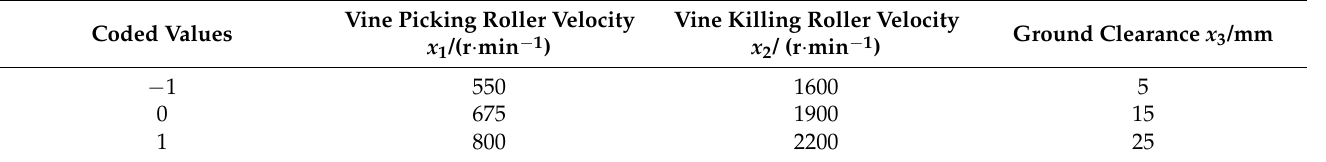
Table 3. Test factors and coded values.